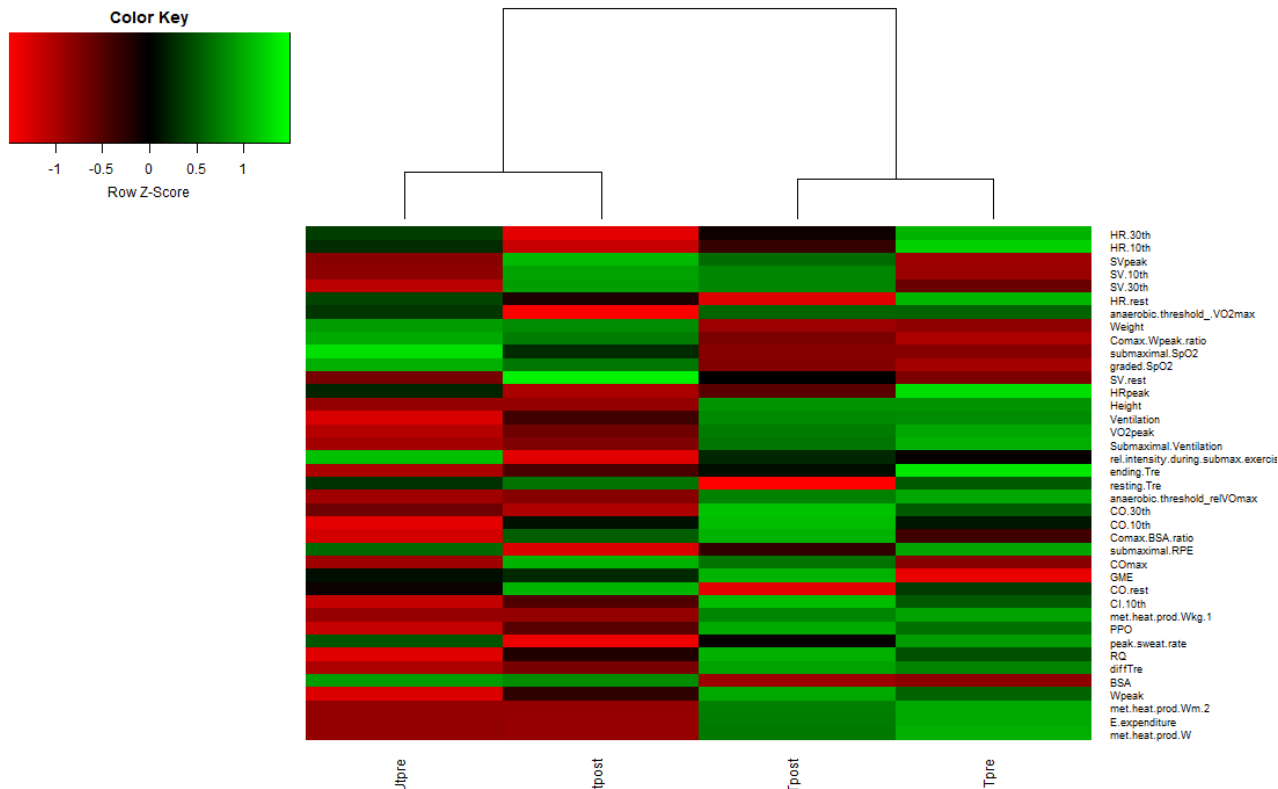
Figure 3. Heatmap representation of the underlying multivariate exercise physicochemical parameters measured in the X-Adapt project. Dendrogram clustering shows differences between the trained and untrained groups in these parameters before and after training. Higher-resolution heatmap can be found in electronic supplementary material. Abbreviations: body surface area (BSA), stroke volume (SV), hearth rate (HR) cardiac output (CO), rectal temperature (Tre), maximal power output (W peak ), peak power output (PPO), gross mechanical efficiency (GME), respiratory quotient (RQ), cardiac index (CI). Please see Figure S2 for the heatmap on representation per sample basis of all participants before and after exercise performance.